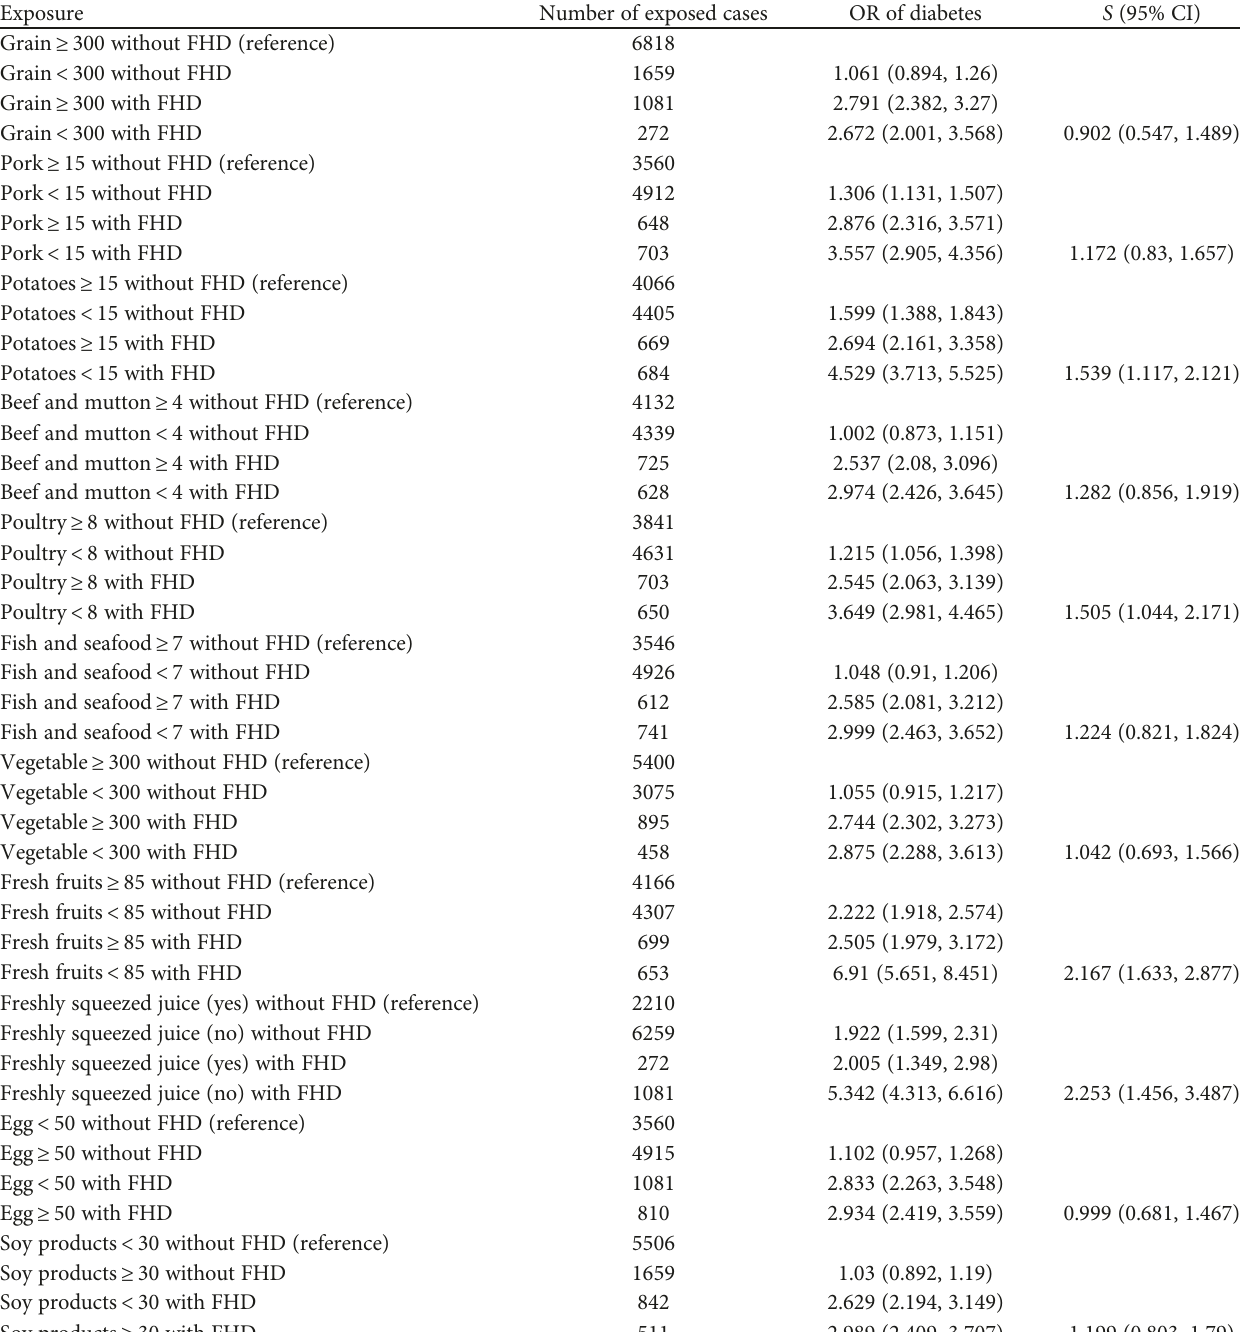
Table 5: Interaction e ff ects between FHD and dietary